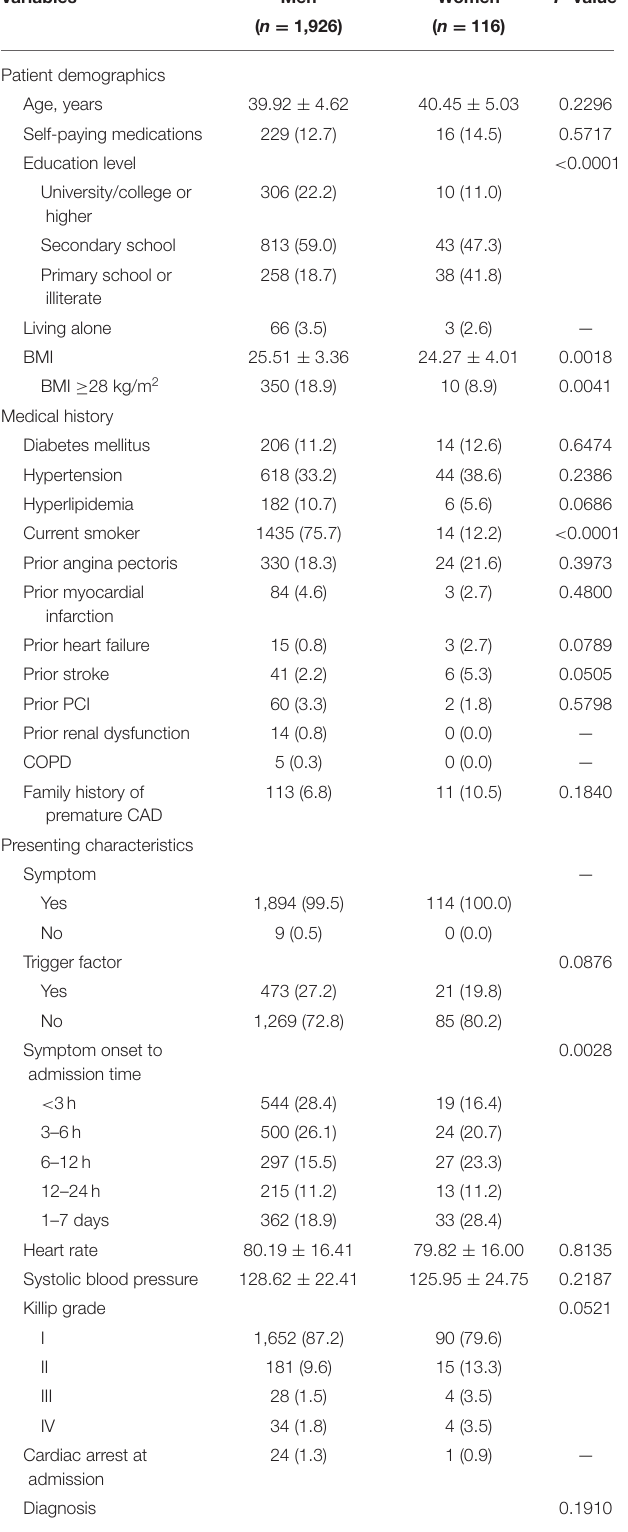
TABLE 7 | Baseline characteristics of young patients stratified by sex.